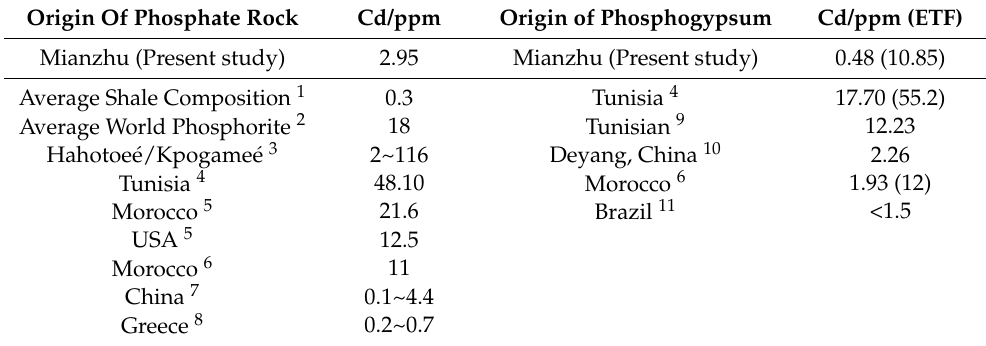
Table 7. Cd content in phosphate rock and phosphogypsum from different